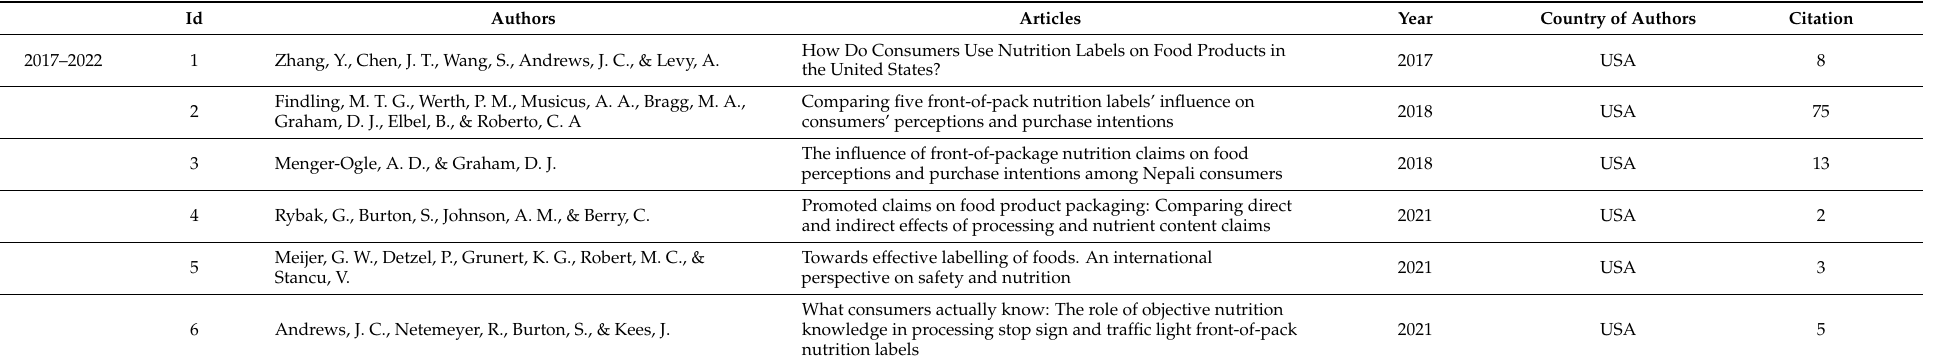
Table 12. Composition of co-citation network 4 in terms of authors, articles, year, country of authors and